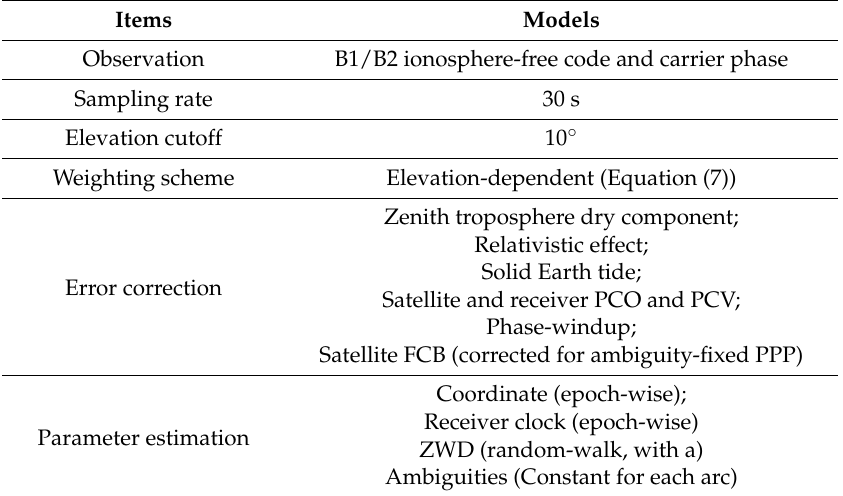
Table 3. Observation models, error processing, and estimated parameters for BDS